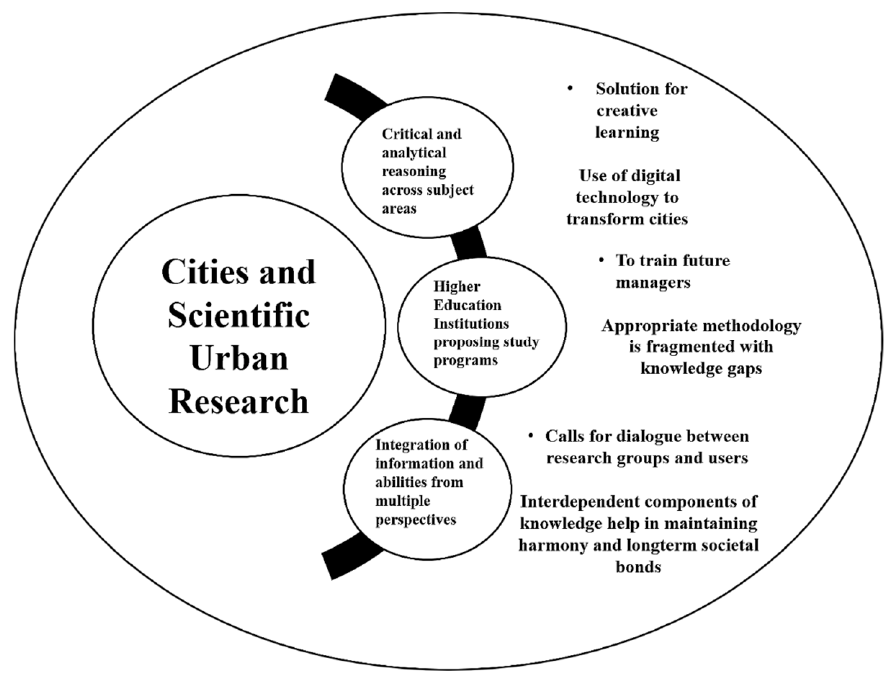
Figure 7. Prospects of a multidisciplinary approach to scientific urban research. Source: Author .